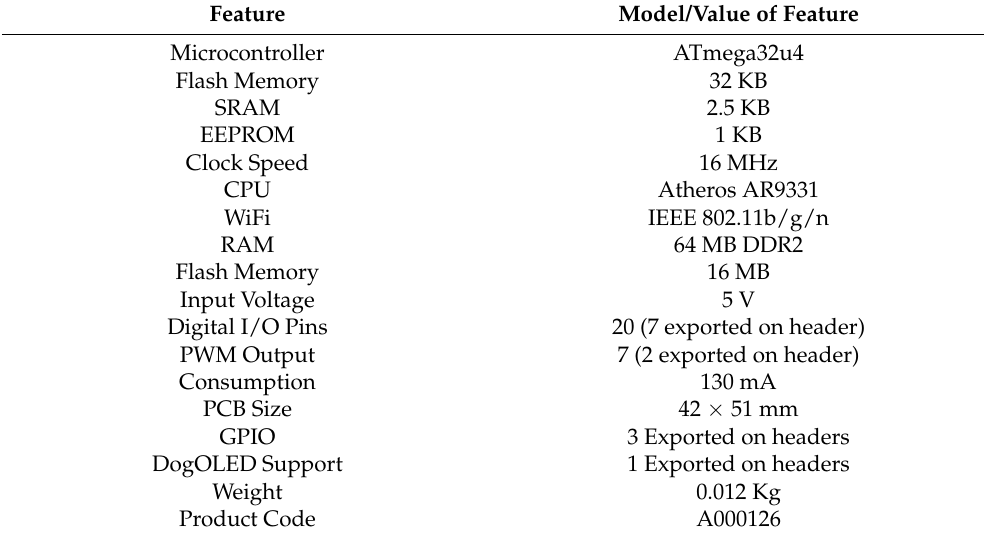
Table 2. Features of the